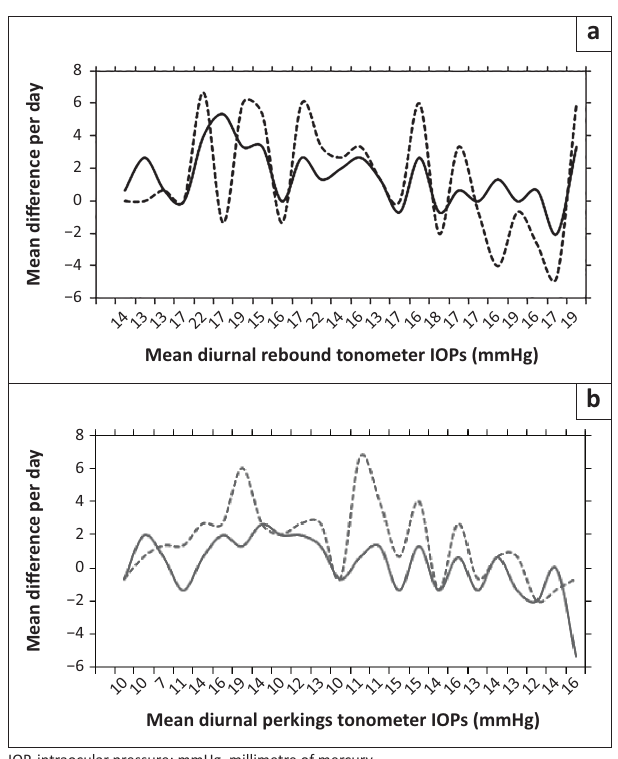
FIGURE 1: Mean difference in intraocular pressure variations between devices. Dotted and solid lines are differences in measurements obtained in supine and sitting positions,